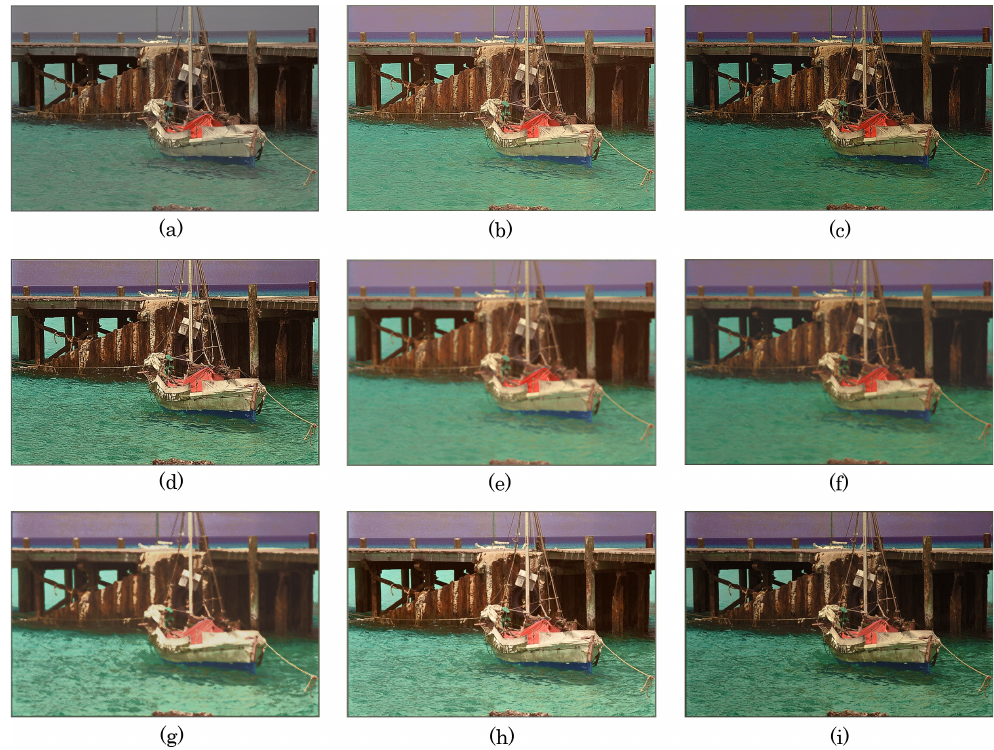
Figure 10. Raw image and output images under proposed method with two types of brightness controls and saturation improvement (kodim11, I S = 20). ( a ) Raw image. ( b ) Sharpening and brightness increase ( I VSH = 2 and I VI = 30). ( c ) Sharpening and brightness decrease ( I VSH = 2 and I VD = 30). ( d ) Sharpening and CE ( I VSH = 2 and I VC = 30). ( e ) Smoothing and brightness increase ( I VSM = 2 and I VI = 30). ( f ) Smoothing and brightness decrease ( I VSM = 2 and I VD = 30). ( g ) Smoothing and CE ( I VSM = 2 and I VC = 30). ( h ) Brightness increase and CE ( I VI = 30 and I VC = 30). ( i ) Brightness decrease and CE ( I VD = 30 and I VC =